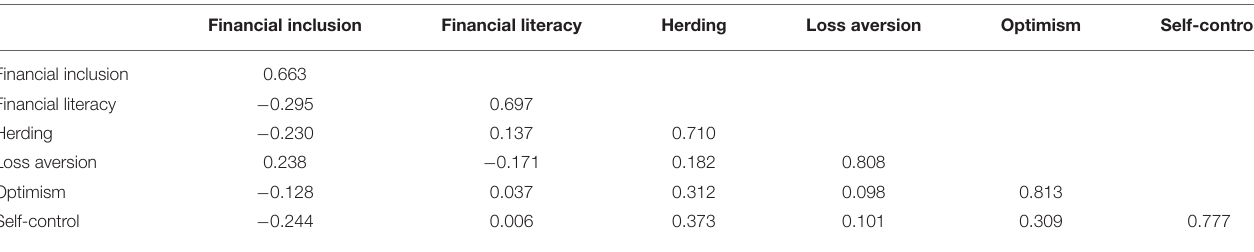
TABLE 3 | Discriminant